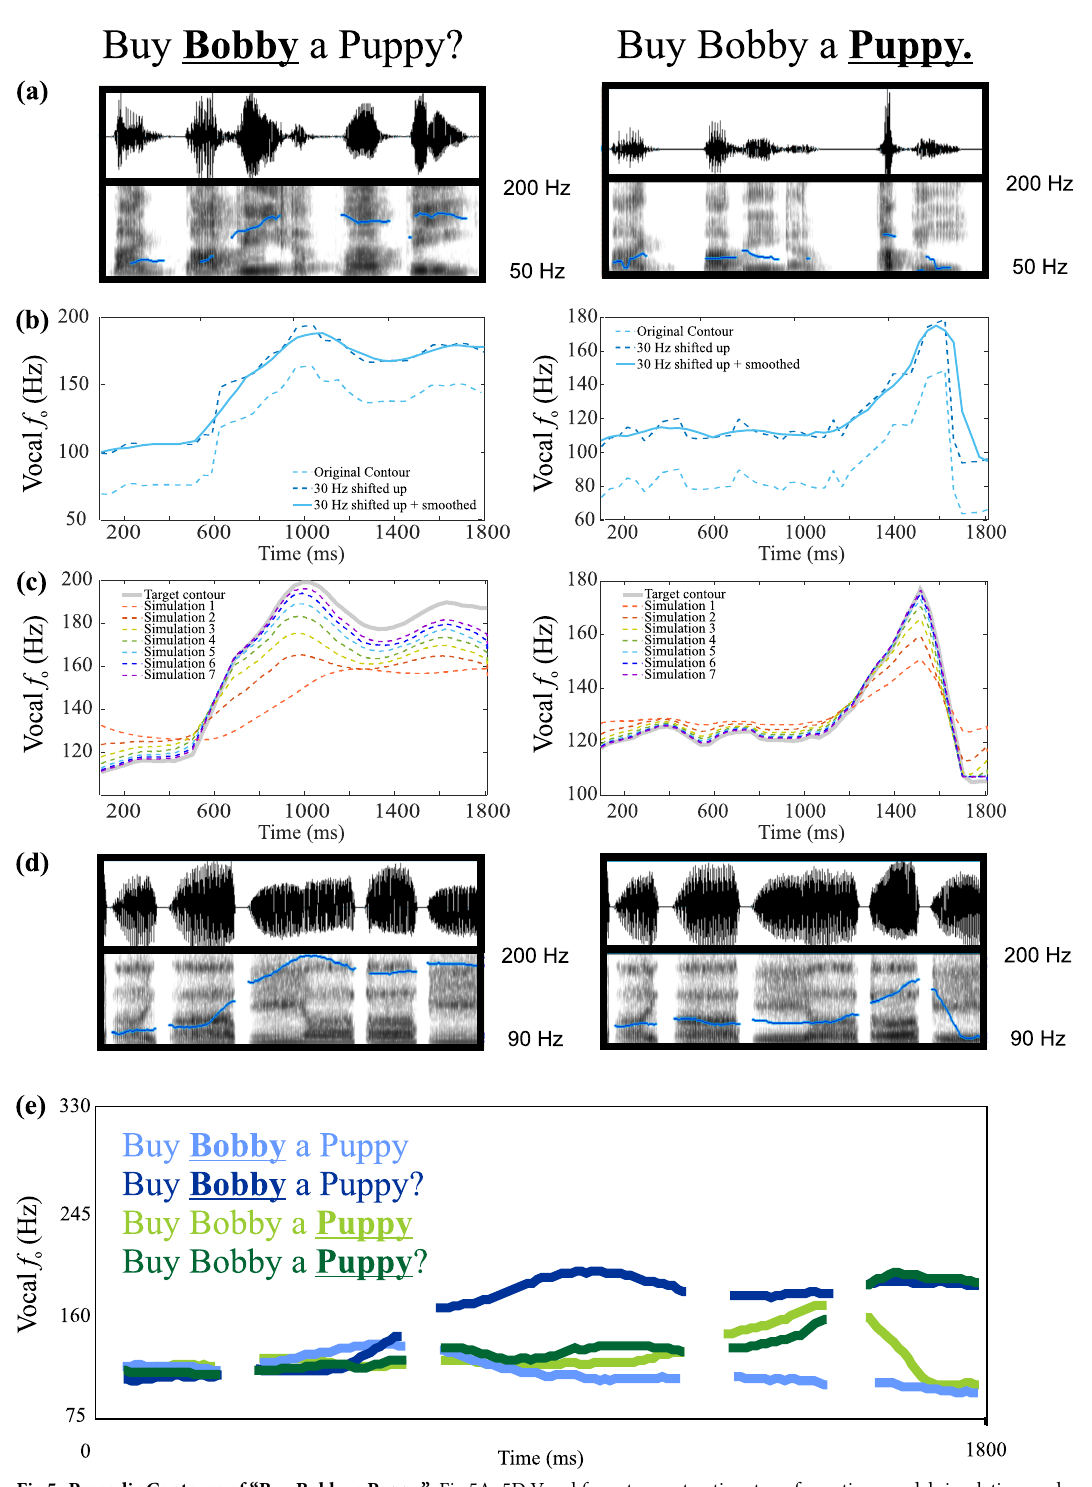
Fig 5. Prosodic Contours of “Buy Bobby a Puppy”. Fig 5A–5D Vocal f contour extraction, transformation, model simulation, and o model synthesis output shown for two intonation patterns. (a) Original recordings recorded from author F.H.G. (male 100 Hz vocal f o ). (b) A baseline vocal f o increase of 30 Hz was applied to all extracted pitch contours to match case B model mean vocal f o of 134 Hz. The pitch contours were smoothed using a 5-point moving-average. (c) Transformed pitch contours were then fed as vocal f o target contours to the model and a sequence of simulations were carried out until the output vocal f contour matched the target o